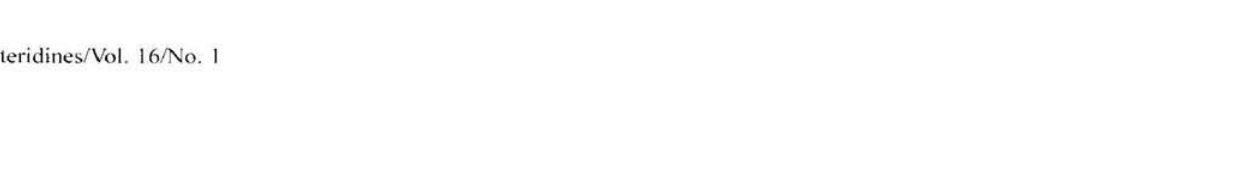
Pteridines/Vol. 16/No.